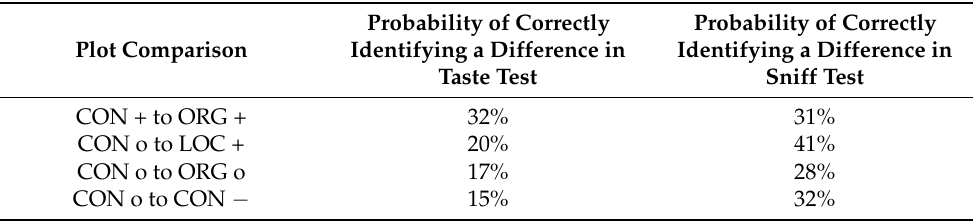
Table 4. Likelihood of correctly identifying a different pair of “Jewel” strawberries grown under different management regimes in two separate sensory evaluations. The taste test compiles observa- tions from 28 panelists, the sniff test compiles observations from 29 panelists. Management regimes: Conventional (CON), Organic (ORG), and Low Carbon Conventional (LOC). Treatments